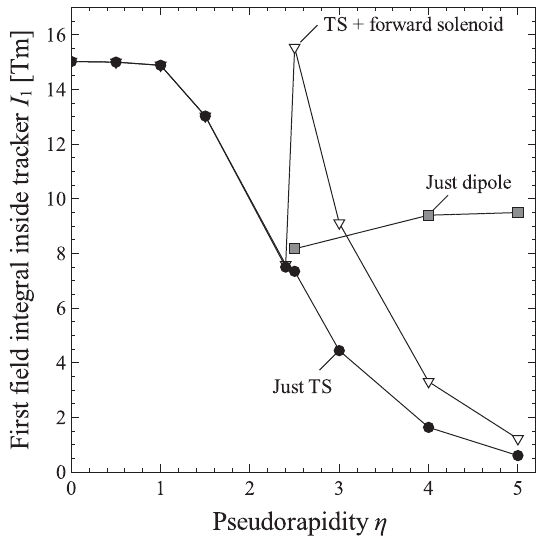
FIG. 7. First field integral I 1 of the twin solenoid and the balanced forward solenoid versus the forward dipole.